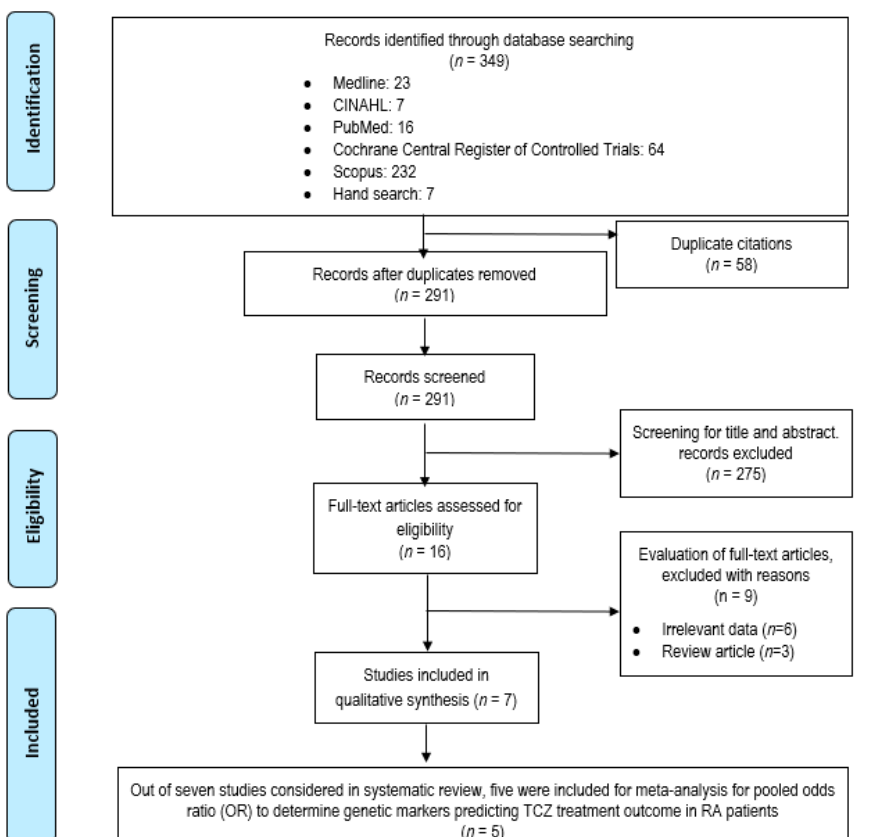
Figure 1. PRISMA flow diagram of study selection process .